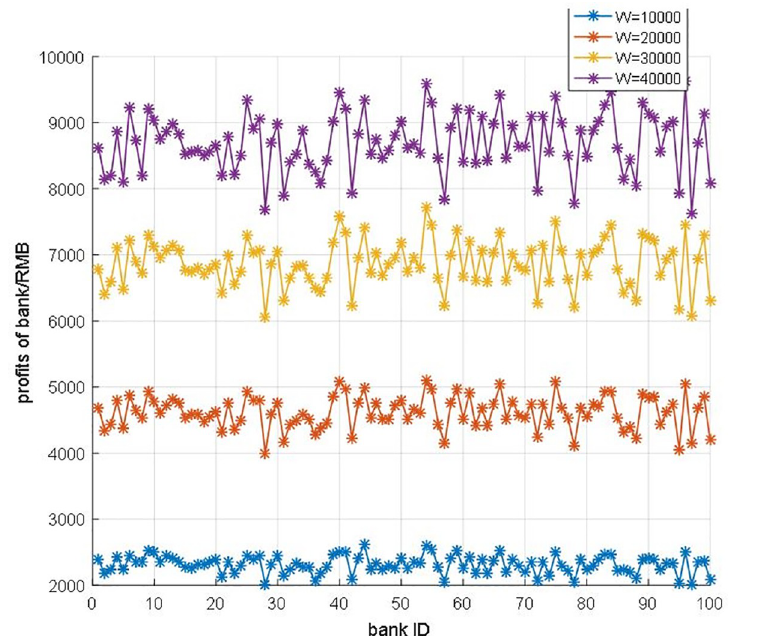
Fig 11. The profits of each bank in different government regulation.